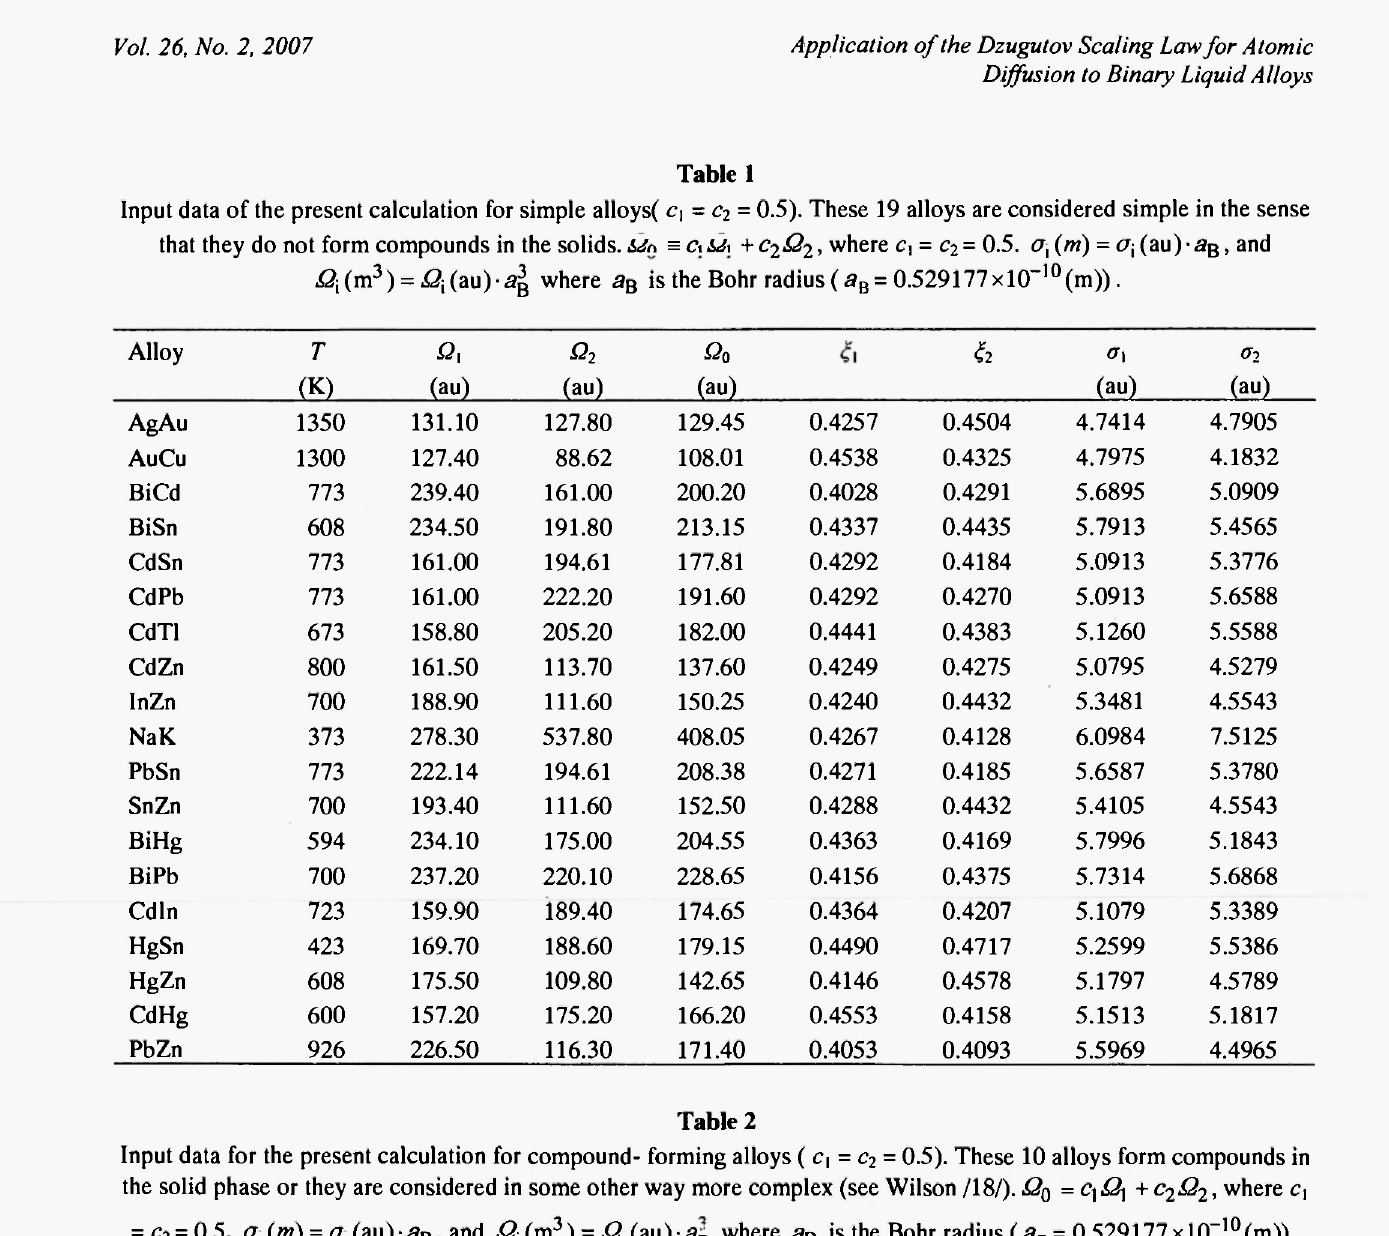
Input data of the present calculation for simple alloys( c, = c 2 = 0.5). These 19 alloys are considered simple in the sense that they do not form compounds in the solids.